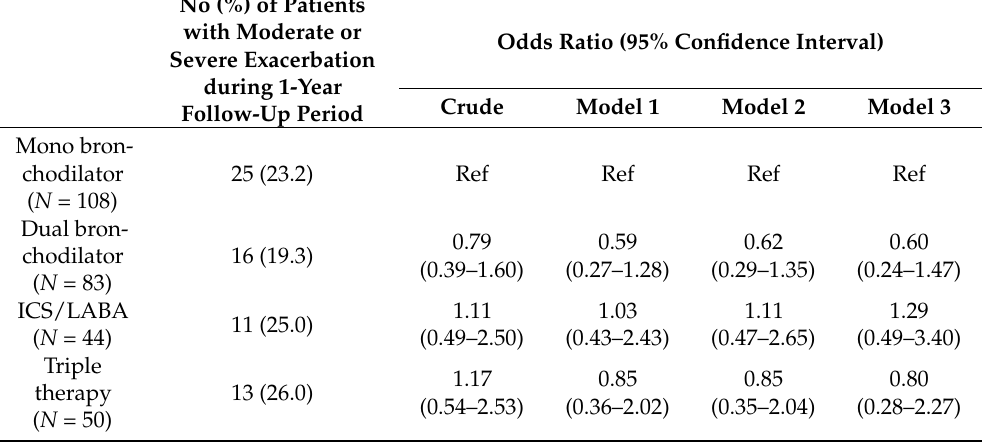
Table 4. The risk of moderate or severe exacerbation in group A COPD patients using mono- bronchodilator therapy as a